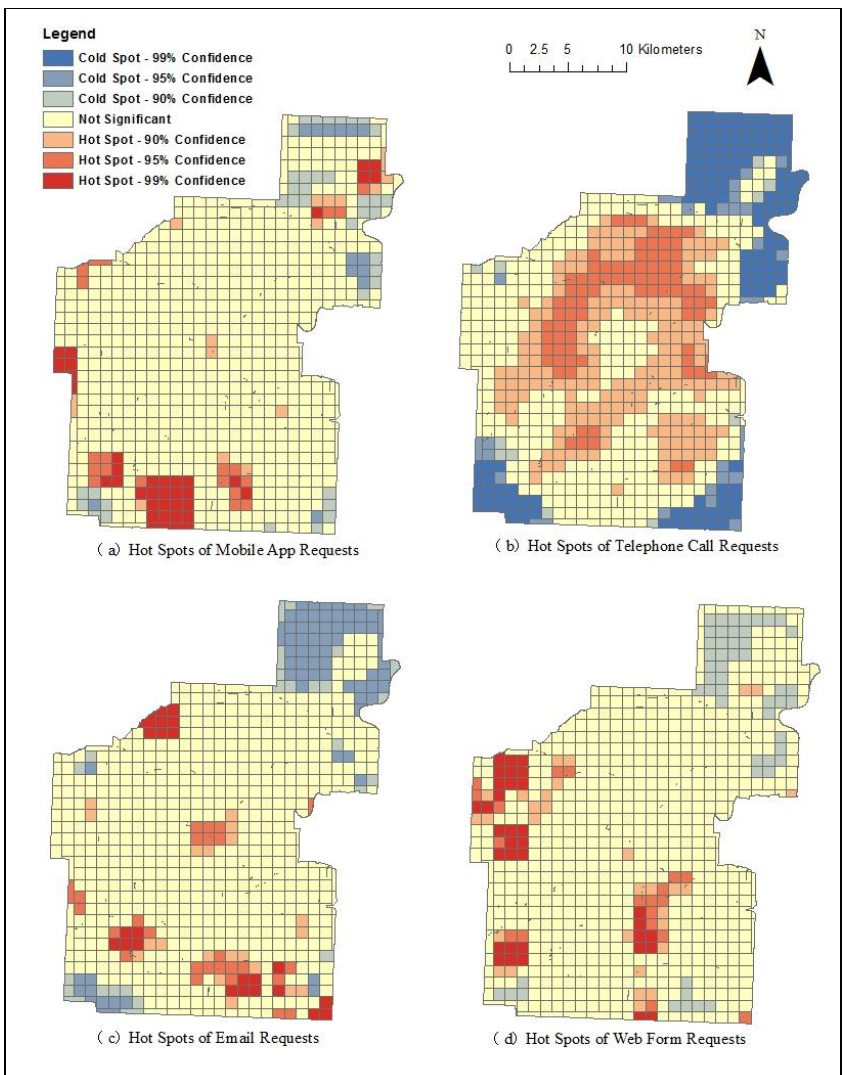
Figure 4. Hot spots analysis results based on percentages of reports from each